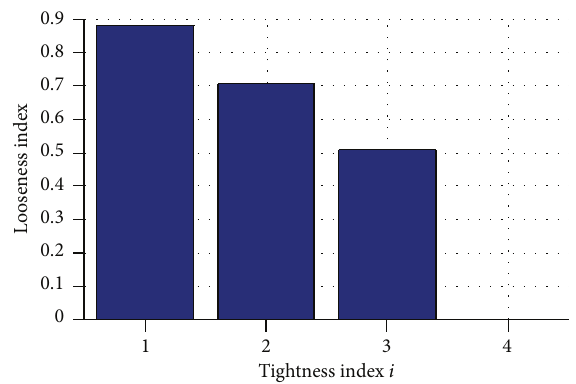
Figure 11: Looseness index (PZT 6 as actuator and PZT 5 as sensor).